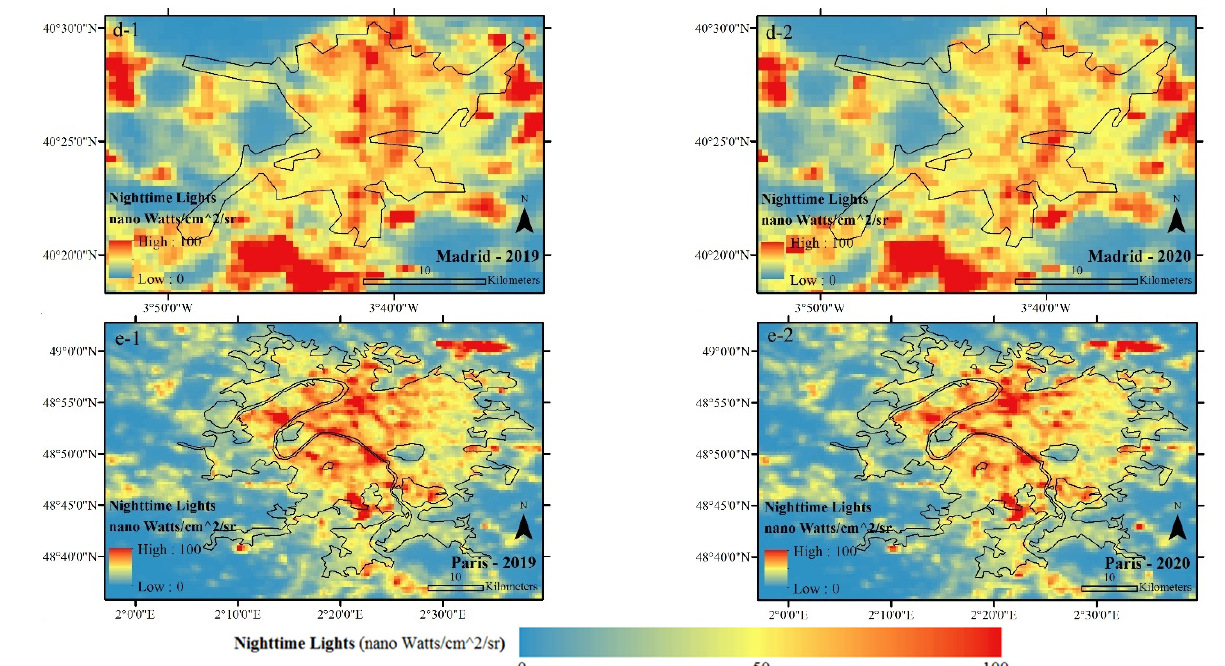
Figure 11. Average NLs of the studied cities during CSR, extracted from VIIRS in nano Watts/cm 2 /sr. ( a-1 ) Average NLs of Berlin in 2019, ( a-2 ) Average NLs of Berlin in 2020, ( b-1 ) Average NLs of Frankfurt in 2019, ( b-2 ) Average NLs of Frankfurt in 2020, ( c-1 ) Average NLs of London in 2019, ( c-2 ) Average NLs of London in 2020, ( d-1 ) Average NLs of Madrid in 2019, ( d-2 ) Average NLs of Madrid in 2020, ( e-1 ) Average NLs of Paris in 2019, ( e-2 ) Average NLs of Paris in 2020.